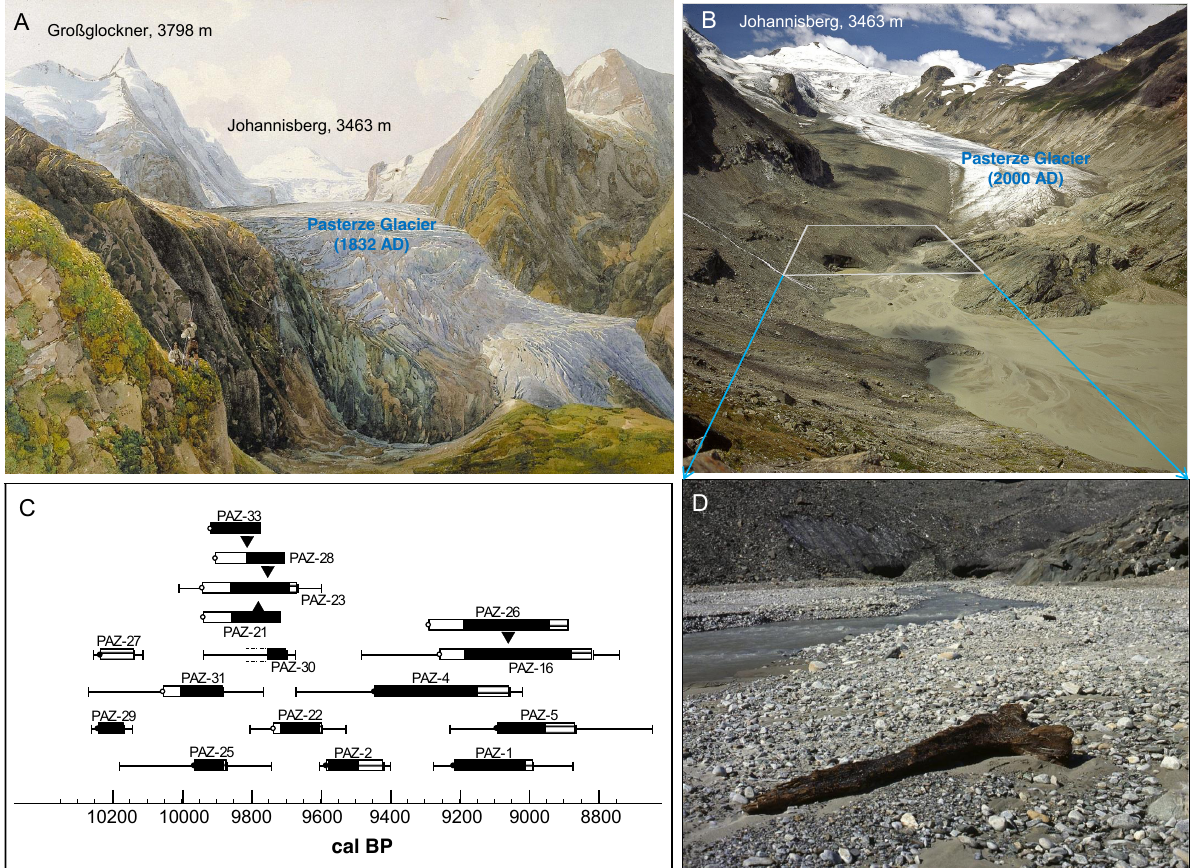
Figure 2 Old wood found in the forefield of the Pasterze Glacier in the Austrian Alps. The dramatic loss of glacier mass can be assessed from the painted landscape of 1832 (A) and the photo of the twindling glacier in 2000 (B). Panel (D) zooms into the trapezoidal section of (B) and shows one log found in the forefield of the glacier. Panel (C) shows the age distribution of all wood specimens collected from the glacier forefield [10] by combining dendro dating (filled sections) with 14 C measurements (error bars indicate 65% calibrated age ranges). The open sections depict missing inner tree-ring sections, and the hatched sections indicate compressed wood. This composite figure is reproduced from Ref.